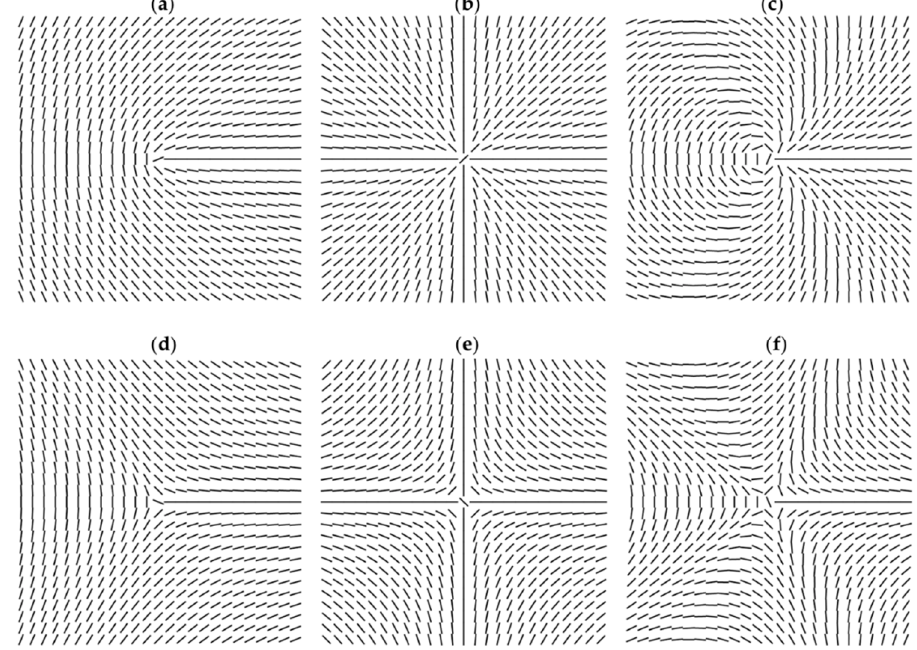
Figure 1. Examples of topological defects (TDs) bearing ( a ) m = 1 / 2; ( b ) m = 1; ( c ) m = 3 / 2; ( d ) m = − 1 / 2; ( e ) m = − 1; ( f ) m = − 3 / 2.